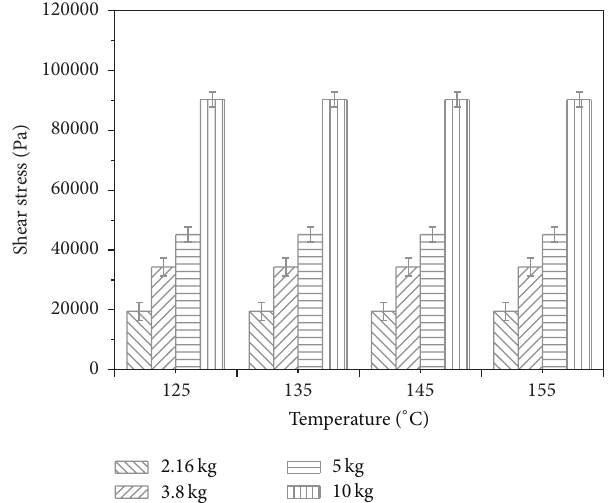
Figure 2: Shear stress versus temperature and indexer’s load and for the blends with 20%, 50%, and 70%